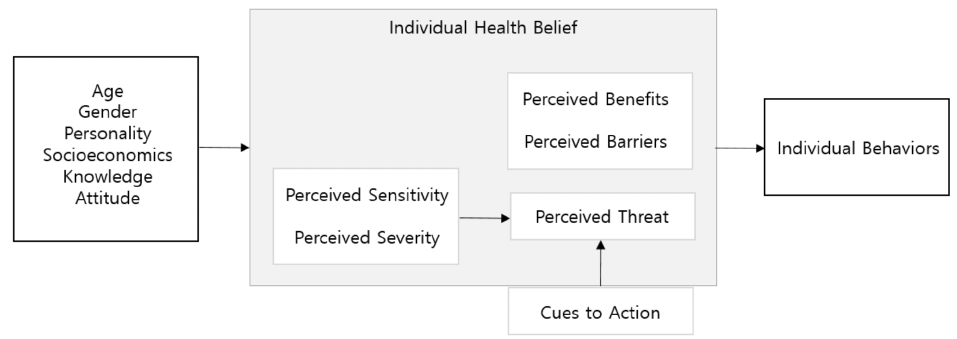
Figure 1. The Health Belief